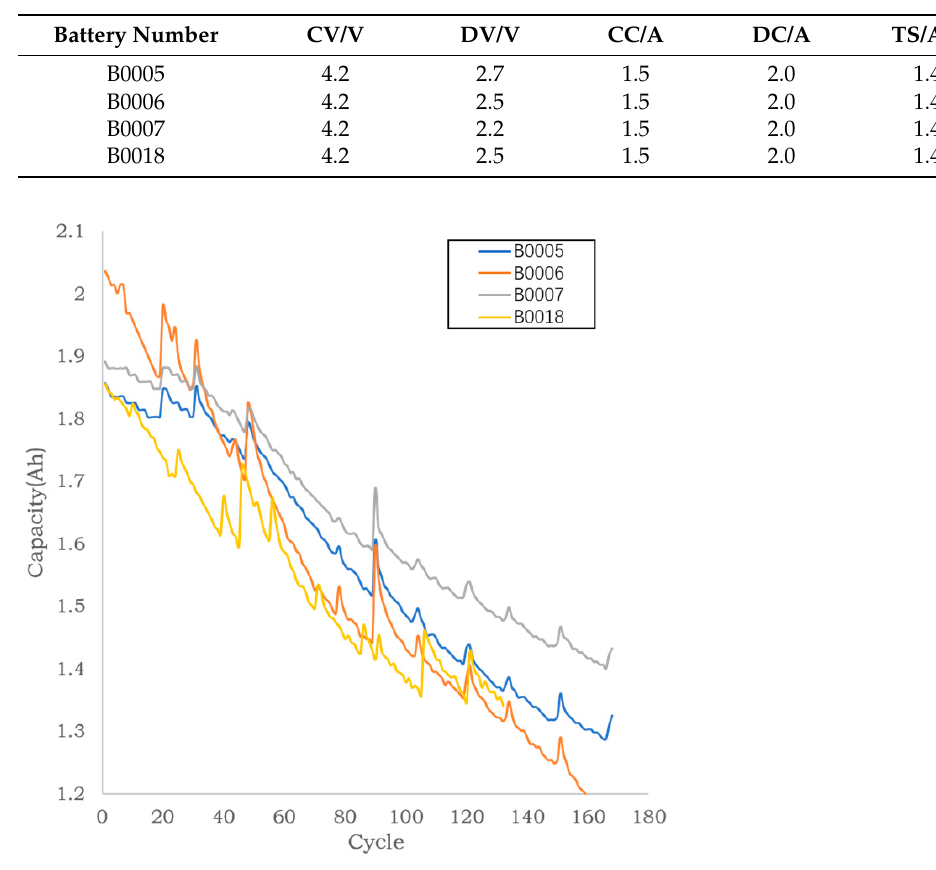
Table 1. Battery parameters in aging experiment.